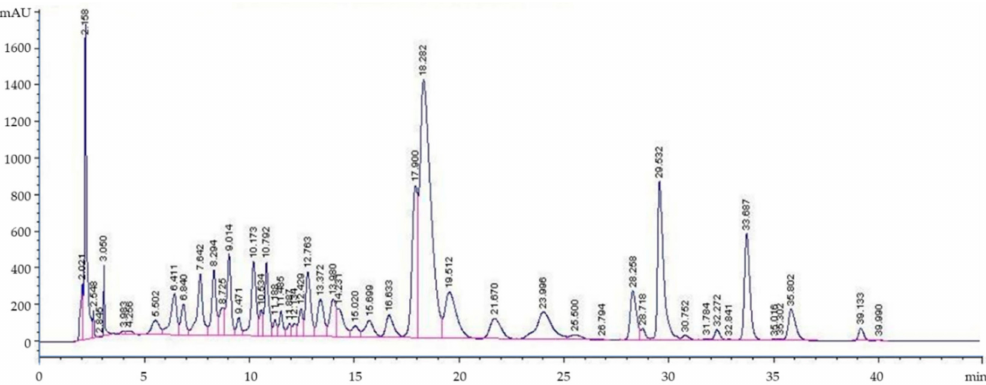
Figure A1. Chromatogram produced by HPLC at 280 nm of the analysis of A. pallida outer tepals expressed in milli- absorbance unit